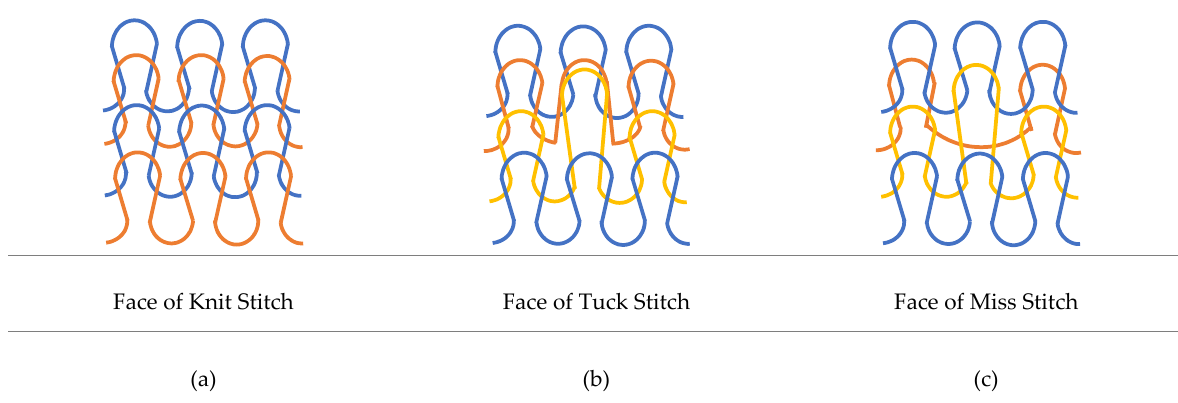
Figure 2. Schematic of 3 types of spacer fabric: ( a ) knit stitch (SF1), ( b ) tuck stitch (SF2), and ( c ) miss stitch